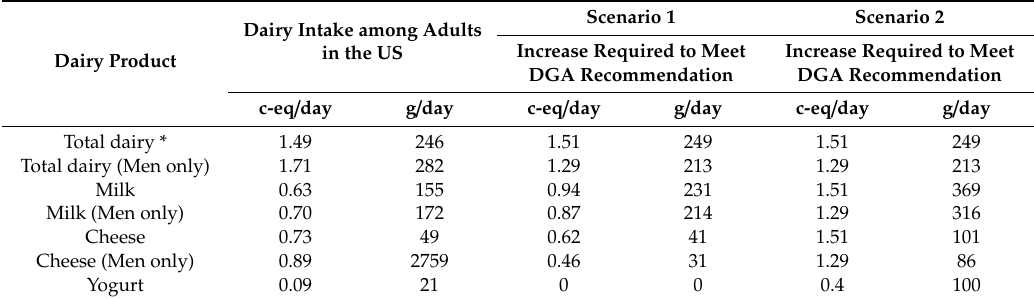
Table 4. Dairy consumption among adults (20 + years) in the United States (WWEIA, NHANES 2015–2016) and increase required to meet the Dietary Guidelines for Americans (DGA) recommendation of 3 cup-equivalents /